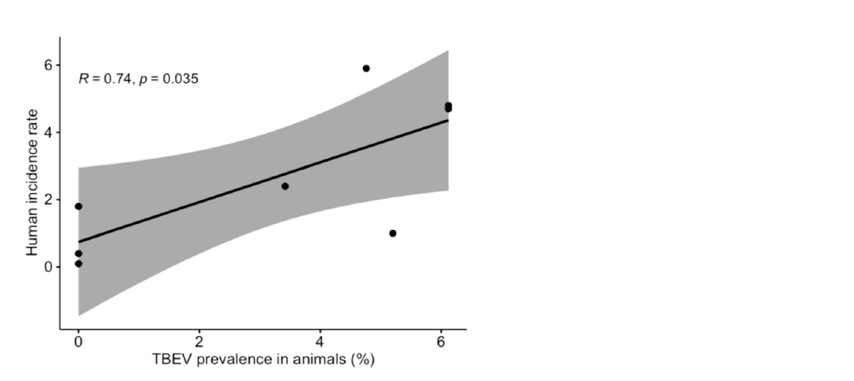
Figure 3. Correlation between TBEV prevalence in animals and human incidence rate (2019 data were used for analysis).